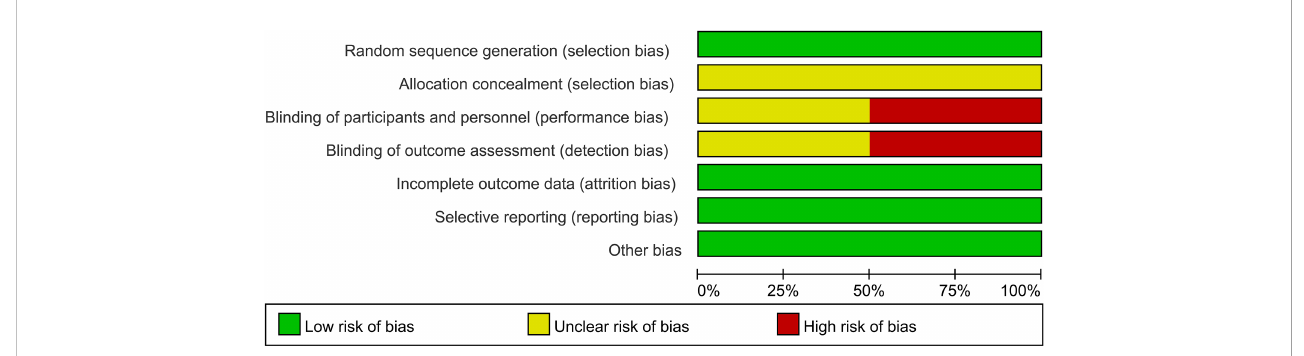
FIGURE 2 Risk of bias assessment for 6 RCTs.